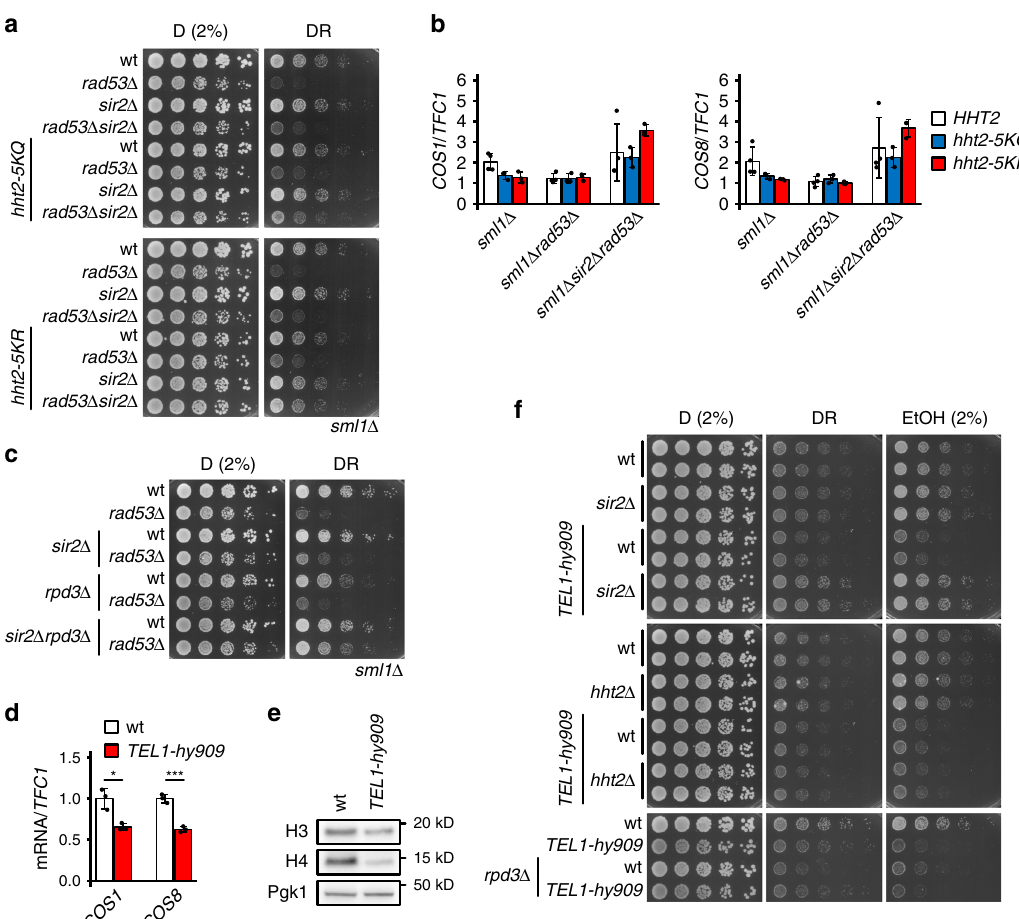
Fig. 4 Separable effect of histone acetylation turnover and subtelomere silencing on glucose requirement. a 10 7 cells/mL were serially diluted (1:6), spotted on YP plates with the indicated carbon sources and grown for 2d. b RT-qPCR quanti fi cation of the expression of the subtelomeric COS1 and COS8 genes in the indicated genotypes 90 min after the switch from glucose to ethanol. Expression levels were normalized to TFC1 . n = 3 ( hht2-5KR and hht2-5KQ mutants) or 4 ( HHT2 ) independent culture replicates. c 10 7 cells/mL were serially diluted (1:6), spotted on YP plates with the indicated carbon sources and grown for 2d. d RT-qPCR quanti fi cation of the expression of subtelomeric genes in wt and TEL1-hy909 cells grown in YP + 3% ethanol. Expression levels were normalized to TFC1 . Signi fi cance was calculated by Student ’ s t test (two-sided, unpaired, p COS1 _ TEL1-hy909 _vs_wt = 0.030, p COS8 _ TEL1-hy909 _vs_wt = 0.00095). n = 3 independent culture replicates. e wt and TEL1-hy909 cells were adapted to YP + 3% ethanol for 20 h and samples were collected during log phase to quantify proteins by western blot analysis. f 10 7 cells/mL were serially diluted (1:6), spotted on YP plates with the indicated carbon sources and grown for 2d. Bar plots with error bars represent mean values and standard deviation, D glucose; DR glucose restriction (0.01% in solid media), EtOH ethanol. * p < 0.05, ** p < 0.01, *** p